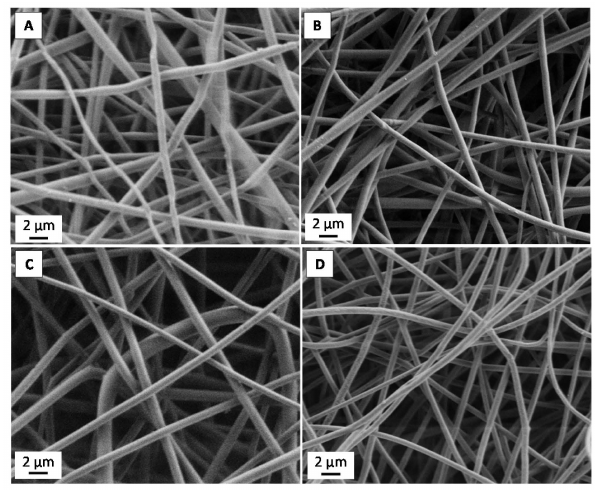
Figure 1. SEM images of PLA samples containing different amounts of biotin: ( A ) 0 wt %; ( B ) 5 wt %; ( C ) 10 wt % and ( D ) 18 wt %.